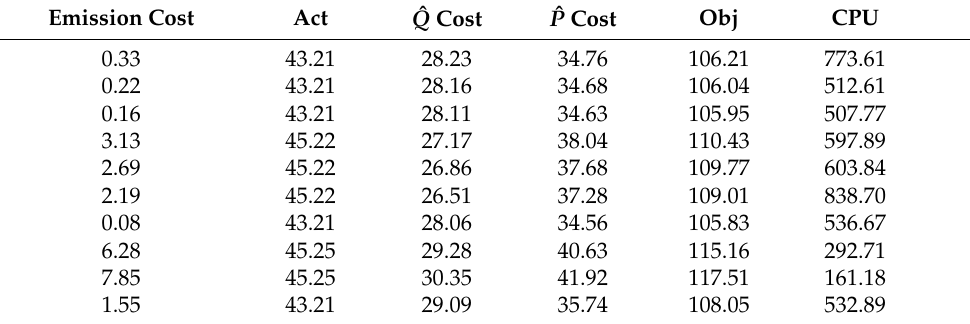
Table 10. Emission cost variation per vehicle.